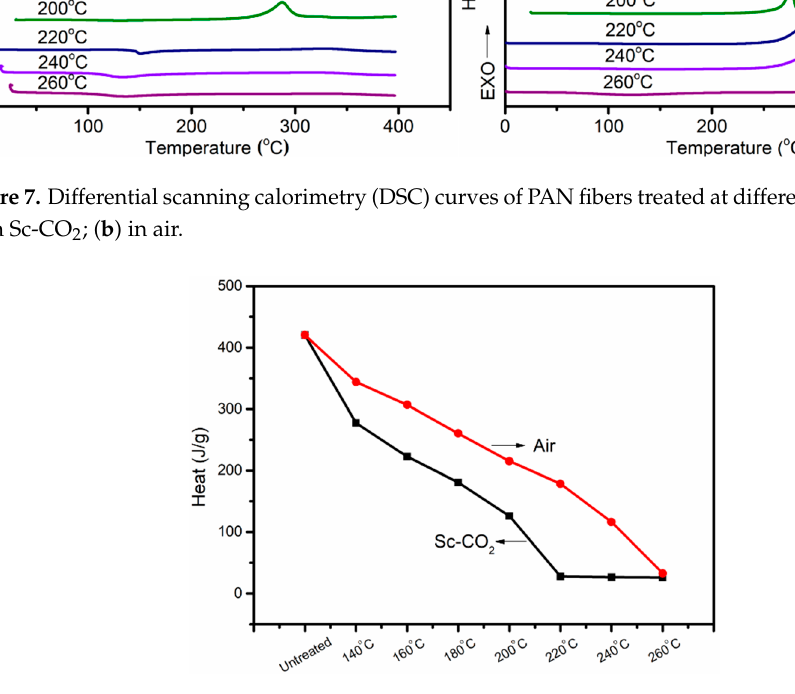
Figure 8. Exotherm of PAN fibers treated at different temperatures in air and Sc-SO 2 .